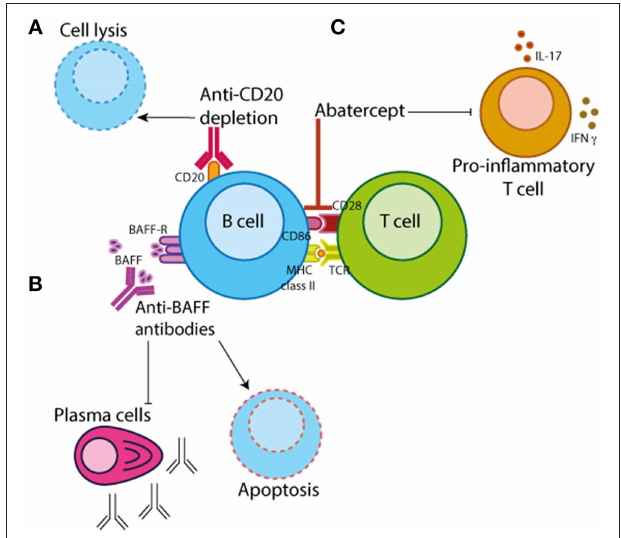
FIGURE 3 | B cell-targeted therapeutics. There are three main categories of B cell targeting therapeutics. (A) Chimeric monoclonal antibodies against CD20 (e.g., rituximab) which target B cells for depletion by antibody-dependent cytotoxicity, complement-mediated lysis or apoptosis. (B) Monoclonal antibodies that bind B cell activating factor/B-lymphocyte stimulator (BAFF/BLyS) (e.g., Belimumab) preventing B cell proliferation and survival. (C) Abatercept, a fusion protein of CTLA-4 and a fragment of the modified Fc domain of human IgG1, that binds to CD28 on T cells preventing the interaction with CD80/CD86 on antigen-presenting cells inhibiting T cell activation and